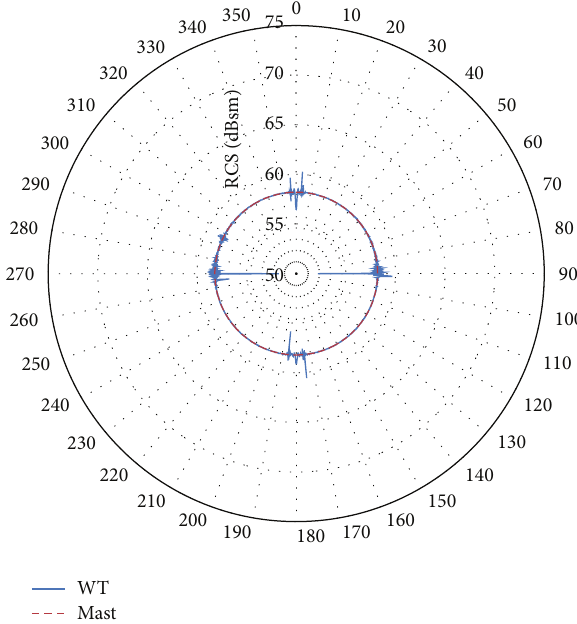
Figure 6: Variation in the horizontal plane of the RCS pattern for the maximum RCS value of the vertical pattern (incidence normal to the mast surface). Wind turbine (blue line) and mast (red dotted line) RCS patterns for turbine model 1 at 3.08 GHz.